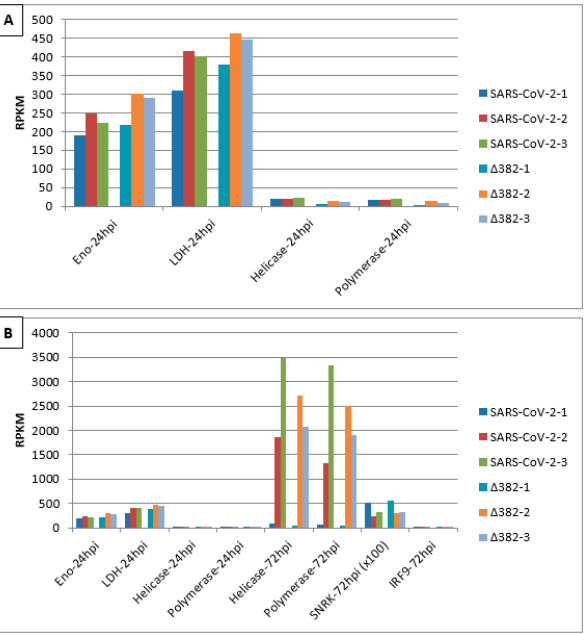
Figure 2. Burst of SARS-CoV-2 virus proliferation at 72 hpi in nasal epithelial cells from three origins infected by two SARS-CoV-2 variants indicates an energy-dependent link to aerobic glycolysis and fermentation at 24 hpi. ( A ) RPKM values of enolase, LDH, helicase and RdRp polymerase transcripts at 24 hpi. ( B ) comparative analysis of RPKM values of enolase and LDH at 24 hpi, helicase and RdRp polymerase transcripts between 24 and 72 hpi as well as SNRK and IRF9 at 72 hpi.